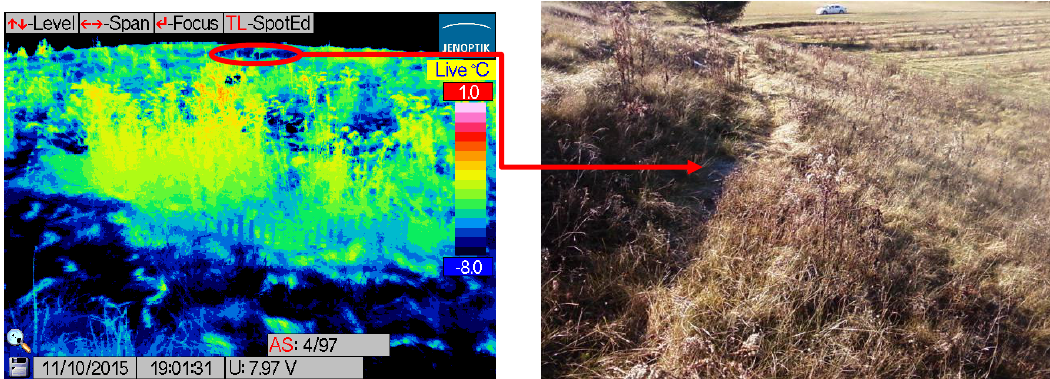
Figure 2 (a) spatial variability of surface temperature, figure 2 (b) show the area prone to frost hollow and cold air pockets